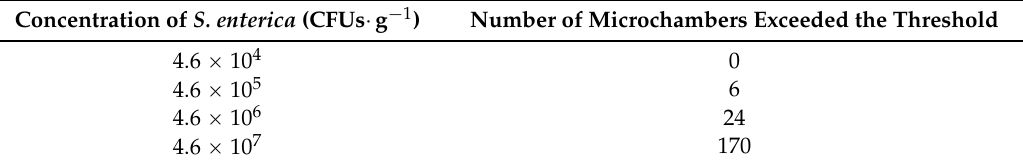
Table 2. Number of microchambers exceeded the threshold.